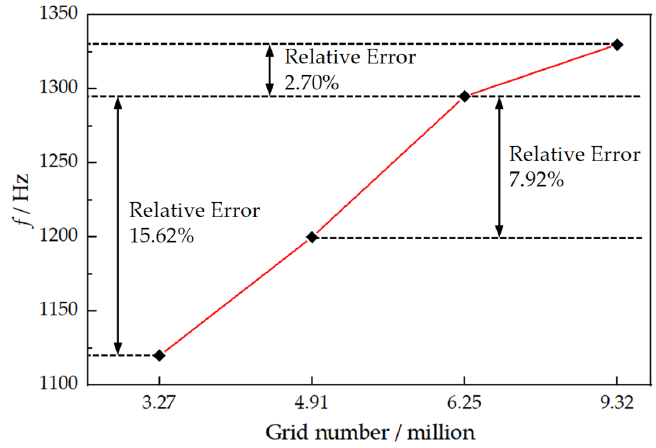
Figure 4. Grid independence